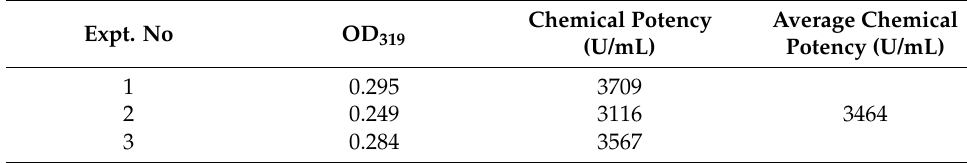
Table 1. Chemical potency detection of Streptomyces noursei